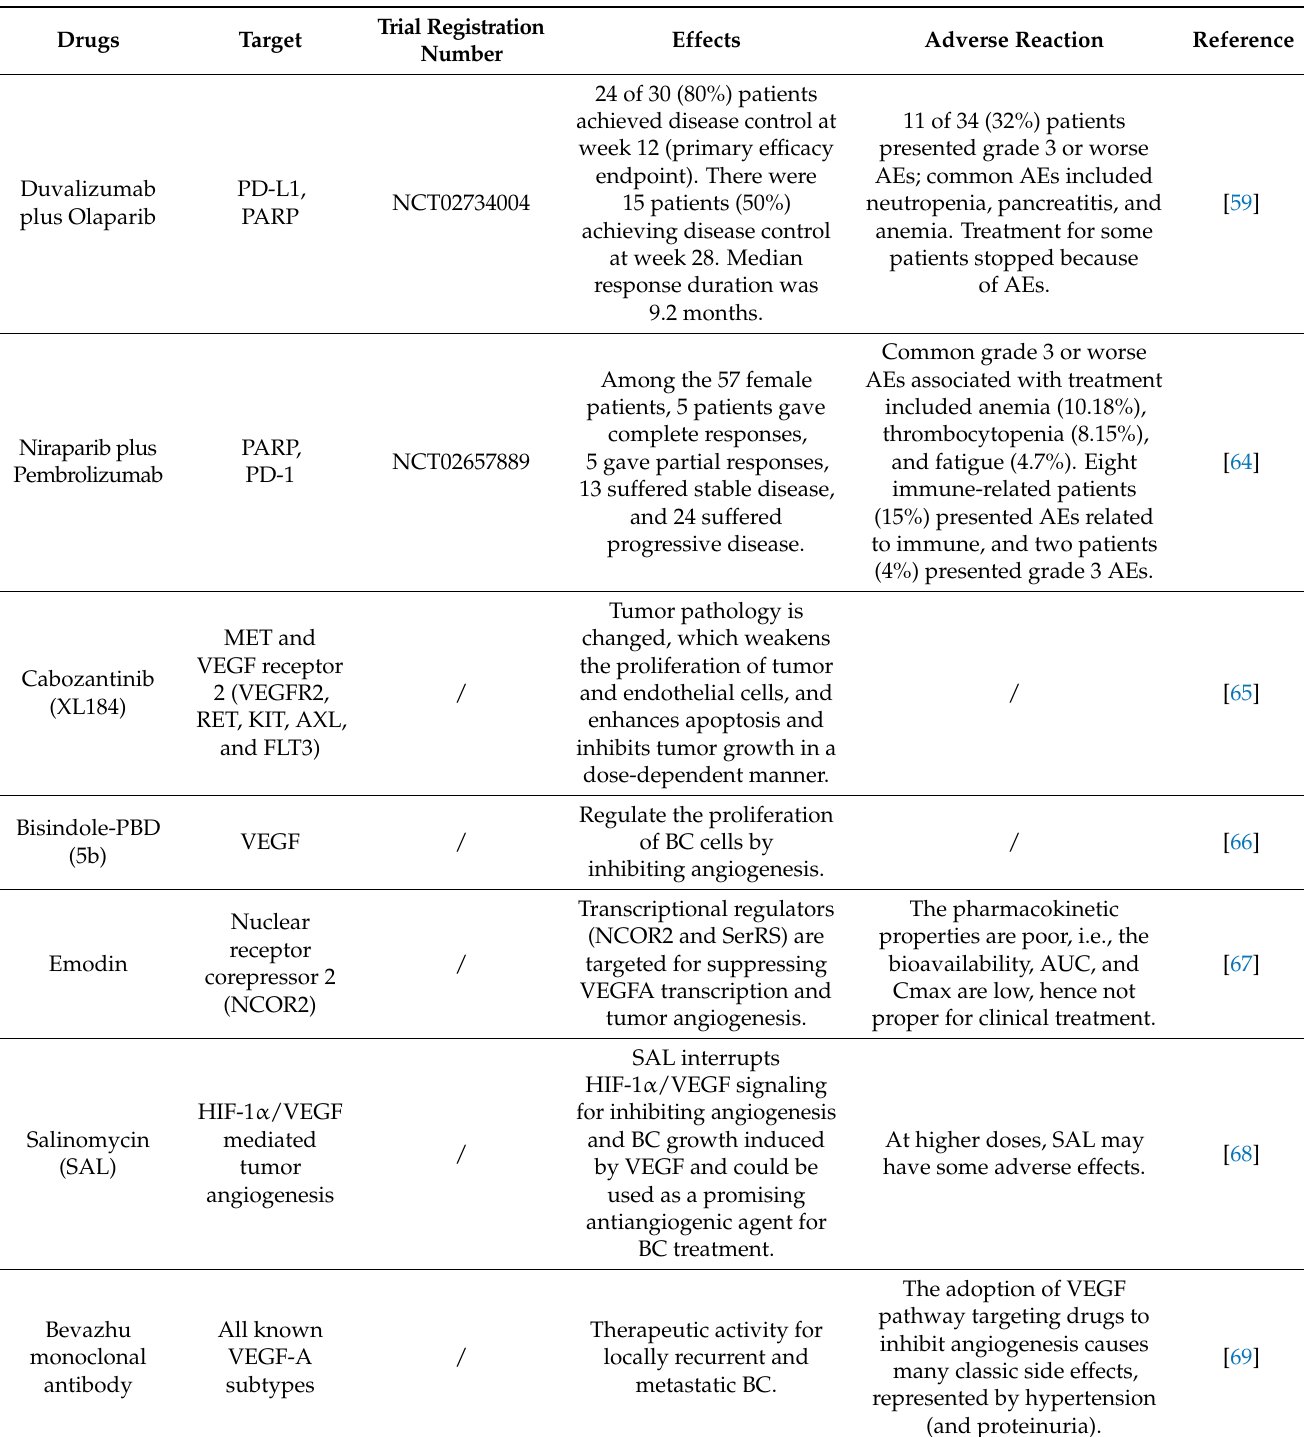
Table 3. Related drugs of PD-1/PD-L1 inhibitors combined with molecularly targeted